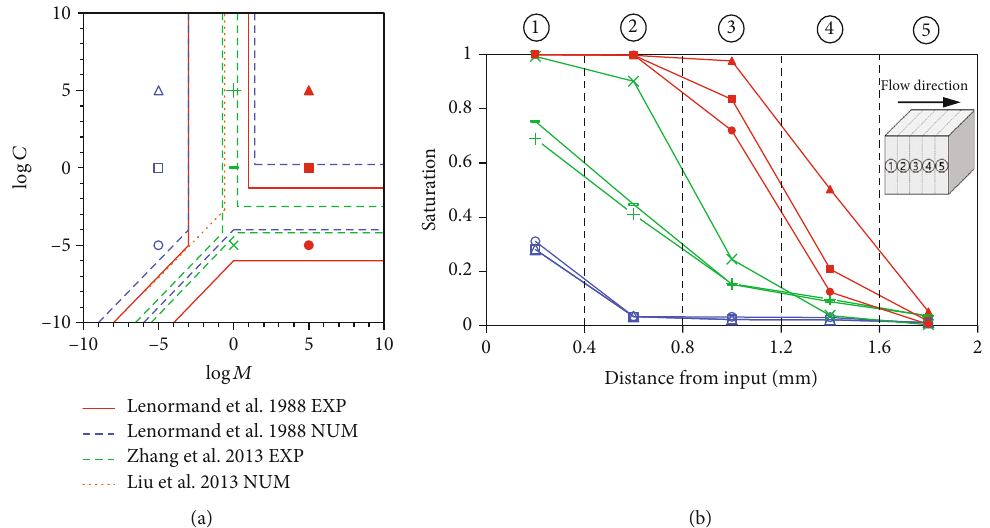
Figure 4: Local saturation of the invading fl uid in the tube network model (with cn = 8 : 0 and σ = σ (a) Nine sets of log M and log C values used to calculate the saturation of the invading fl uid, superimposed on phase boundaries suggested by other researchers. Each symbol represents log M and log C conditions used for the local saturation plot in (b). (b) Local saturation of the invading fl uid with respect to the distance from an input boundary.